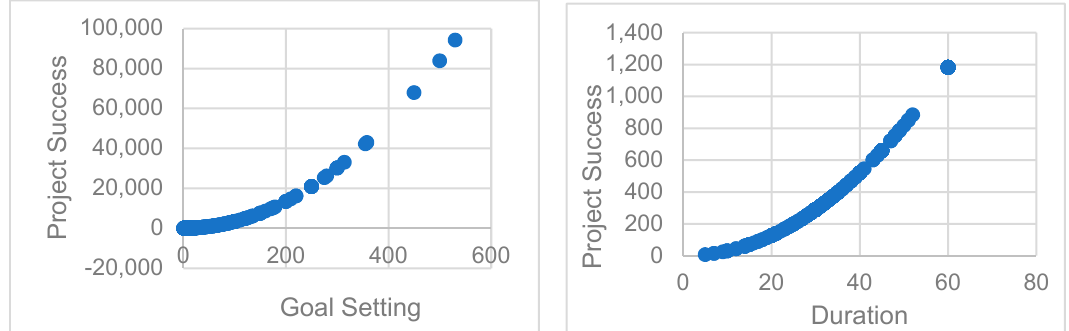
Figure 4. The non-linear effect of goal setting (left) and Duration (right) on project success.